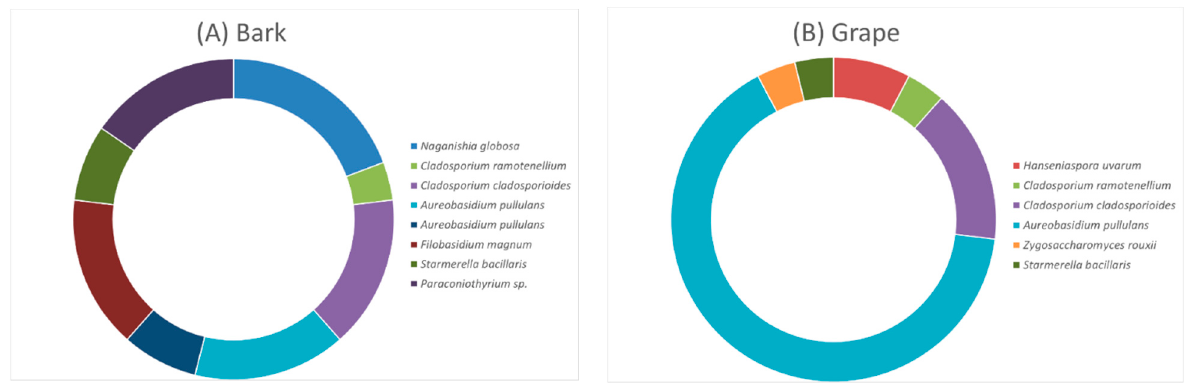
Figure 4. Distribution of fungal profiles recovered from all samples (organic and conventional vineyard) at different sampling times, plotted according to sample source: ( A ) Bark (30 sequences); ( B ) Grape (22 sequences).